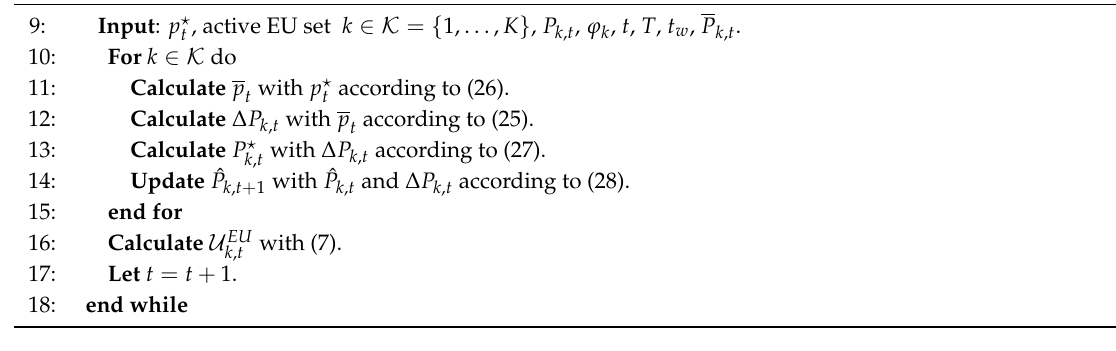
Algorithm 2. Energy-User’s Profit Maximization (Market-adaptive Electricity-Usage Scheduling Algorithm, lines 9–17, performed by the EU).